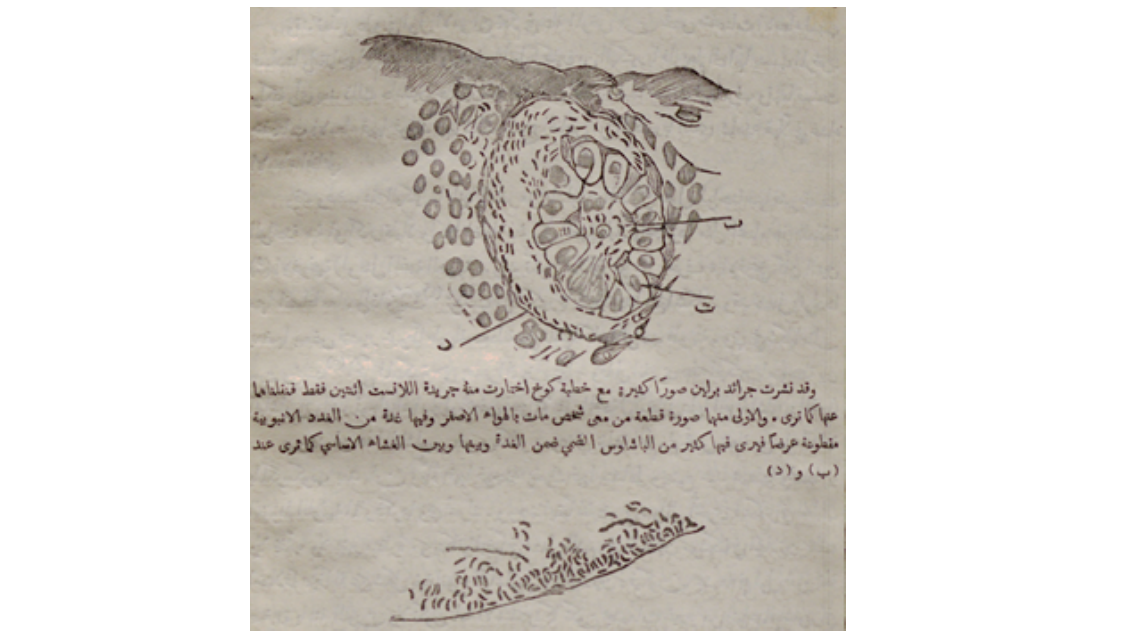
Figure 2. Detail, illustration of cholera bacilli in the intestine (Source: ‘Kalam al-Duktur Kukh fi al-Hawa’ al-Asfar’, al-Muqtataf 9, no. 2 (1884): 67 © British Library